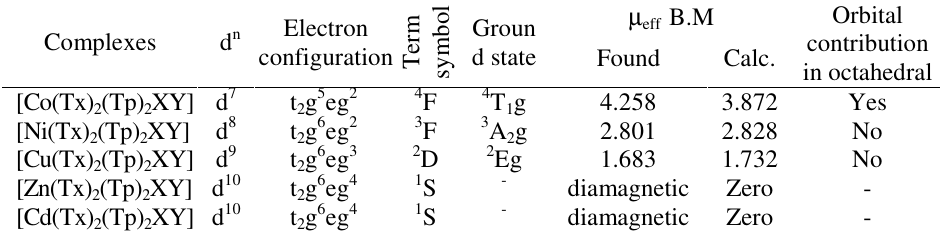
Table 3. The magnetic properties of the complexes at 25 ºC